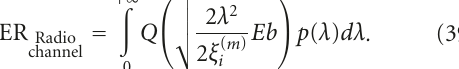
multiuser interference is high, and the bit energy dispersion is large which implies a poor performances. To improve the performance of the system, it is necessary to increase the spreading factor. When we increase the spreading factor the dispersion of the bit is lower [31] and the